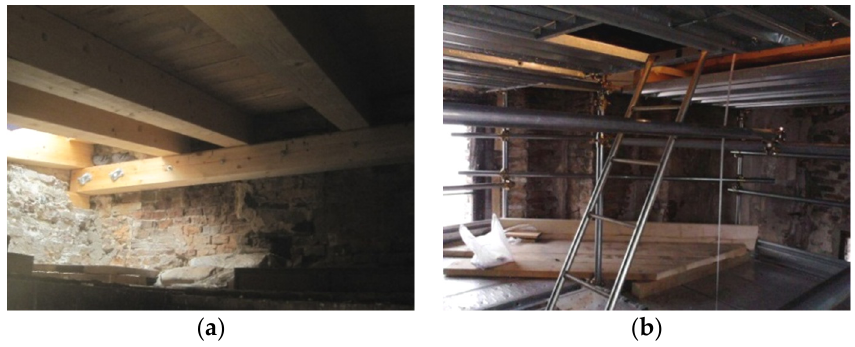
Figure 5. Details of ( a ) the added wooden roof and ( b ) the provisional scaffoldings.